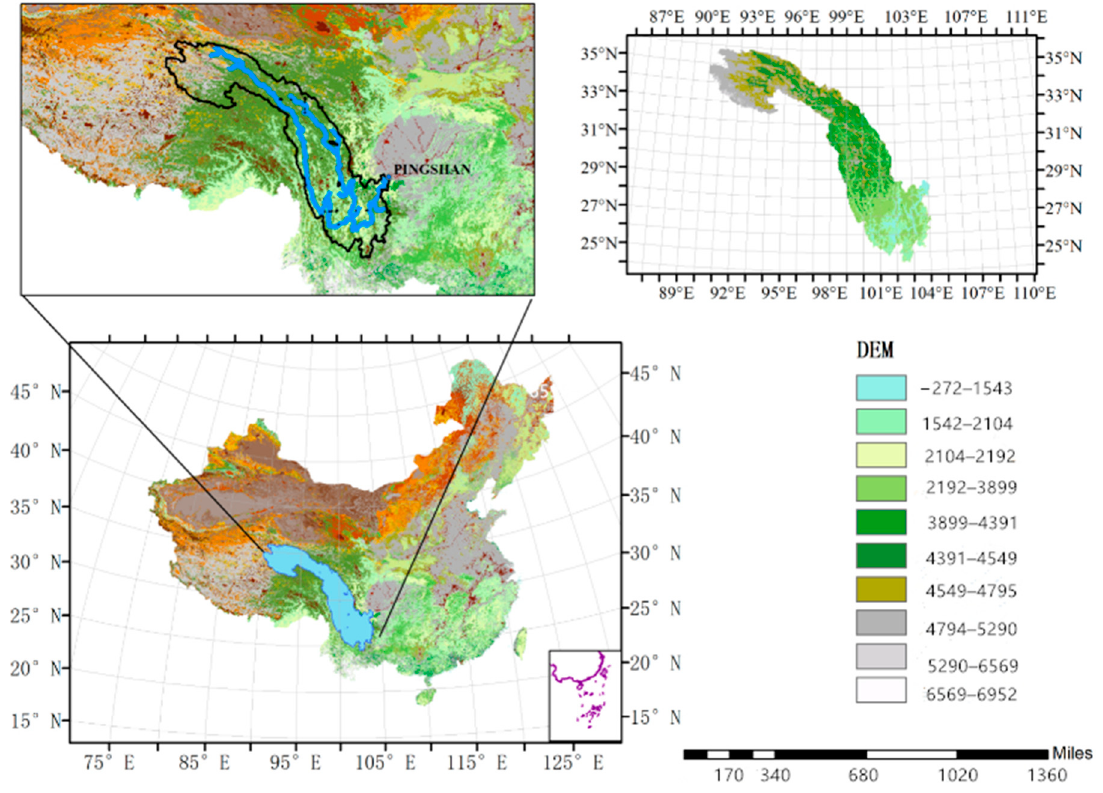
Figure 2. The Jinsha River Basin.